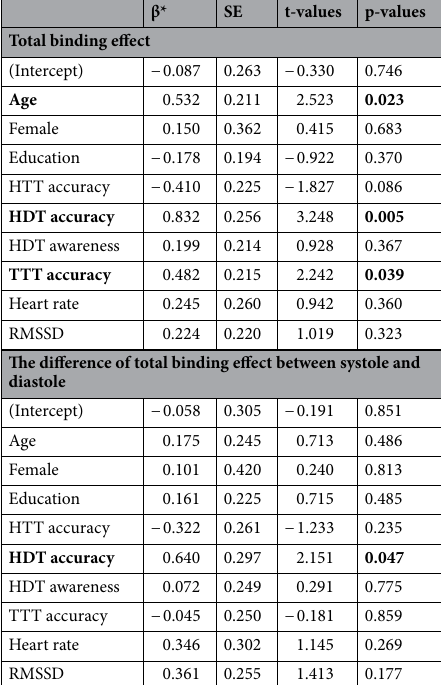
Table 1. General linear models for binding effects. SE Standard error, HTT Heartbeat Tracking Task, HDT Heartbeat Discrimination Task, TTT Time Tracking Task, RMSSD Root Mean Square of the Successive Differences. *Standardised values.